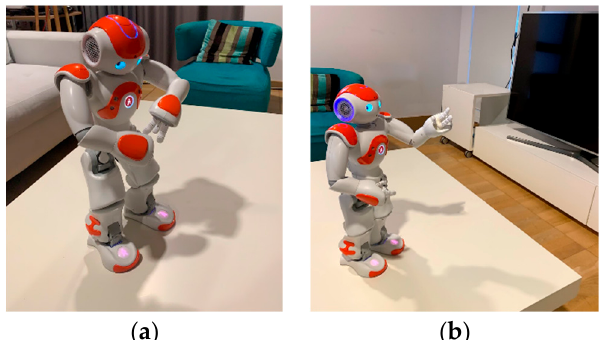
Figure 8. ( a ) NAO points to an imaginary watch when referring to time; ( b ) NAO points towards the ceiling lights.